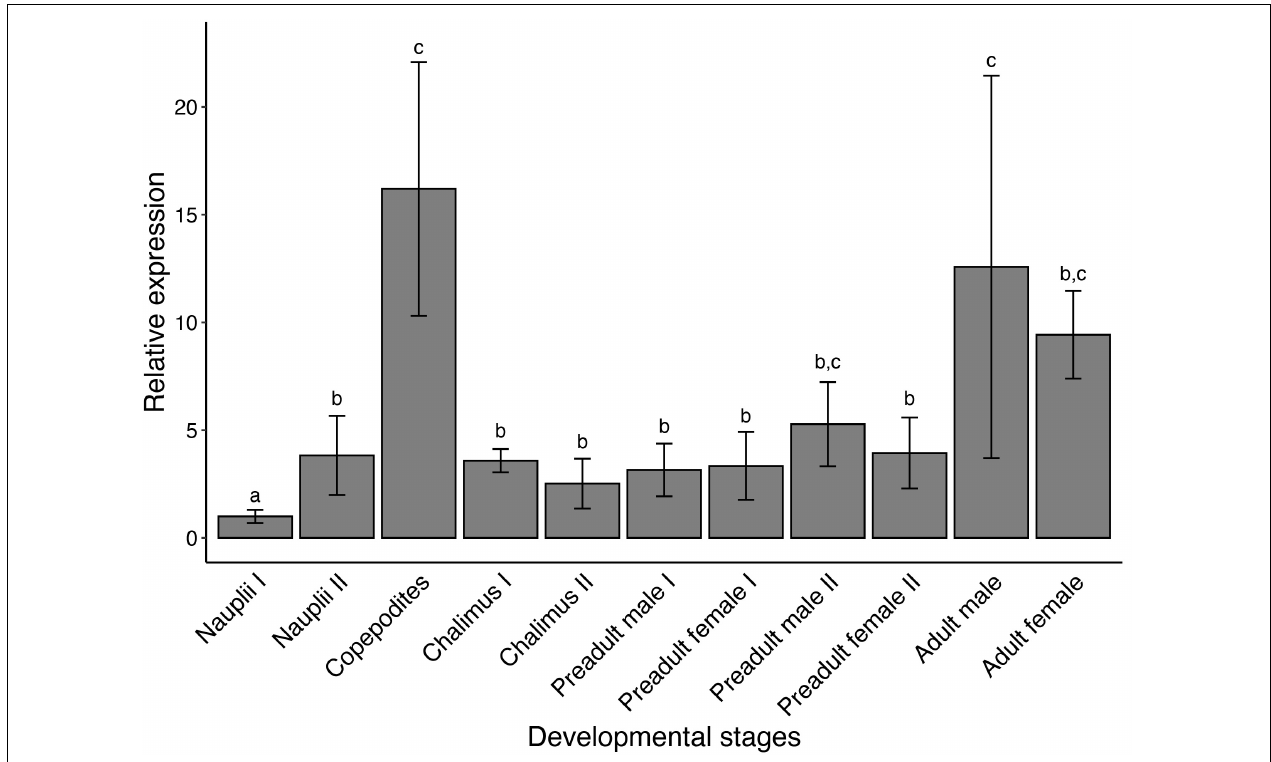
FIGURE 3 | Developmental expression profile of LsPAH . Expression of the transcript levels of LsPAH in salmon louse developmental stages relative to transcript level in the nauplius I. Error bars represent the SE ( n = 4 independent biological replicates). Each biological replicate contained 50 individuals for planktonic life-stages (nauplii I, nauplii II, and copepodites), five individuals for chalimus I and chalimus II and one individual each for pre-adult and adult life-stages. Data were analyzed using qBaseplus+ and one-way ANOVA was performed. Life stages labeled with different letters are significantly different from each other ( p < 0.001).